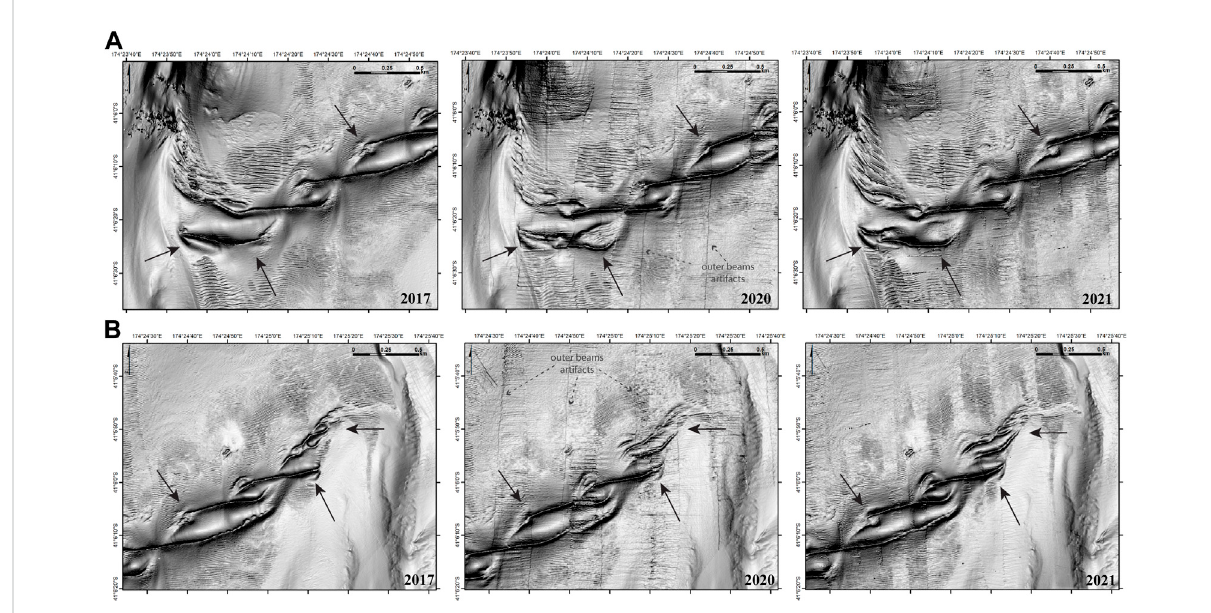
FIGURE 6 Detailofduneswithsuperimposedmegaripplesmappedin2017(left),2020(central)and2021(right),closetoshore (A) ,andseawardattheend of the bedform fi eld (B) (see location of zoom-inareas in Figure5). Black arrows point to locations with the most prominent morphological changes between the three surveys. (Note: due to substantially deteriorated sea state during the 2020 survey, there is additional artifacts in this dataset, manifestingaslinearouterbeamnoisethatremainsevenafterprocessingthedata).Fordepthinformationofthearea,refertoFigure3showing depth contour lines (spaced 10 m). Greyscale shaded relief uses slope (rather than hillshade) to represent sea fl oor features, to reduce bias from arti fi cial light source elevation and azimuth.